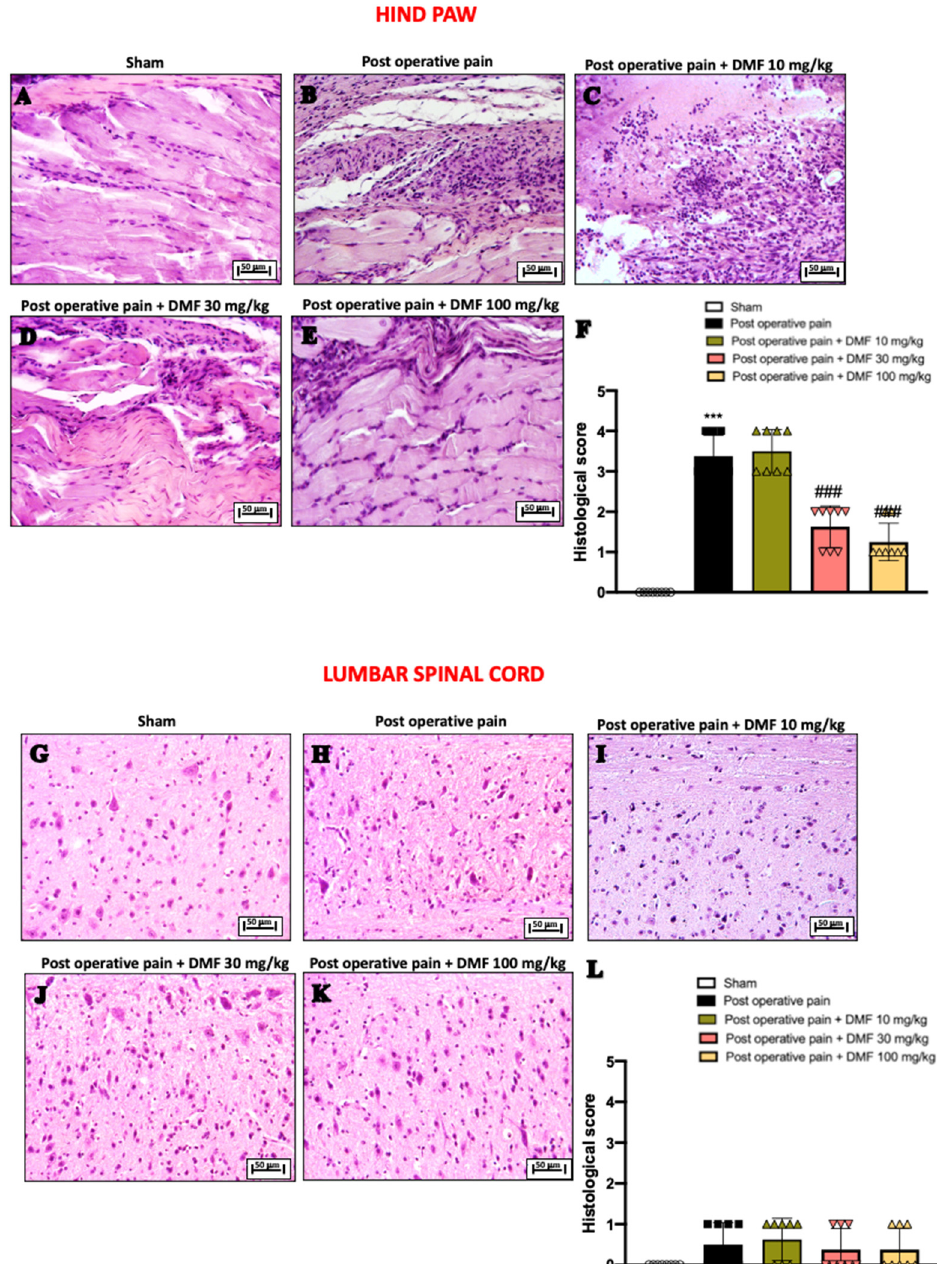
Figure 2. DMF treatment reduced histological damage following PO pain induction. Histological analysis of hind paw: sham ( A ), PO pain ( B ), DMF 10 mg/kg ( C ), DMF 30 mg/kg ( D , E ), DMF 100 mg/kg and histological score ( F ). Histological analysis of lumbar spinal cord: sham ( G ), PO pain ( H ), DMF 10 mg/kg ( I ), DMF 30 mg/kg ( J ), DMF 100 mg/kg ( K ) and histological score ( L ). Magnification at 20×. A p -value of less than 0.05 was considered significant; *** p < 0.001 vs. sham, ### p < 0.001 vs. PO pain.